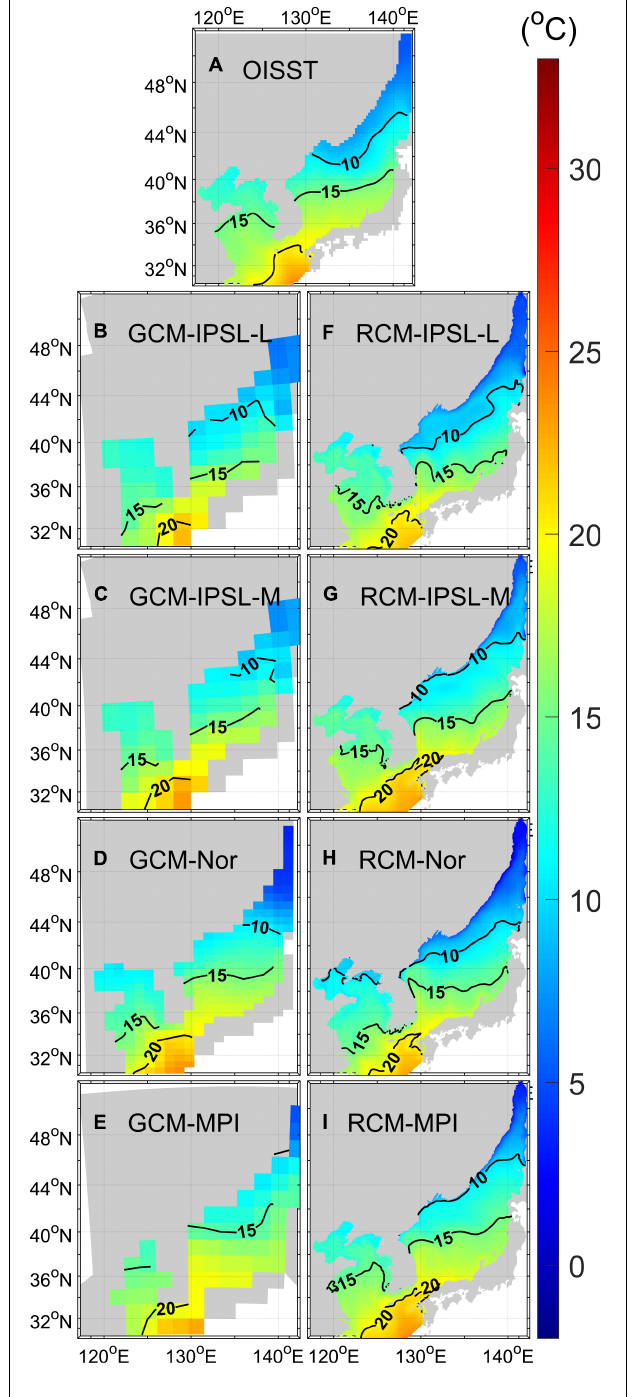
FIGURE 3 | Mean SSTs (units: ◦ C) in the NWP marginal seas: (A) SST from OISST satellite observations, (B–E) GCMs, and (F–I) RCMs, 1982–2005.